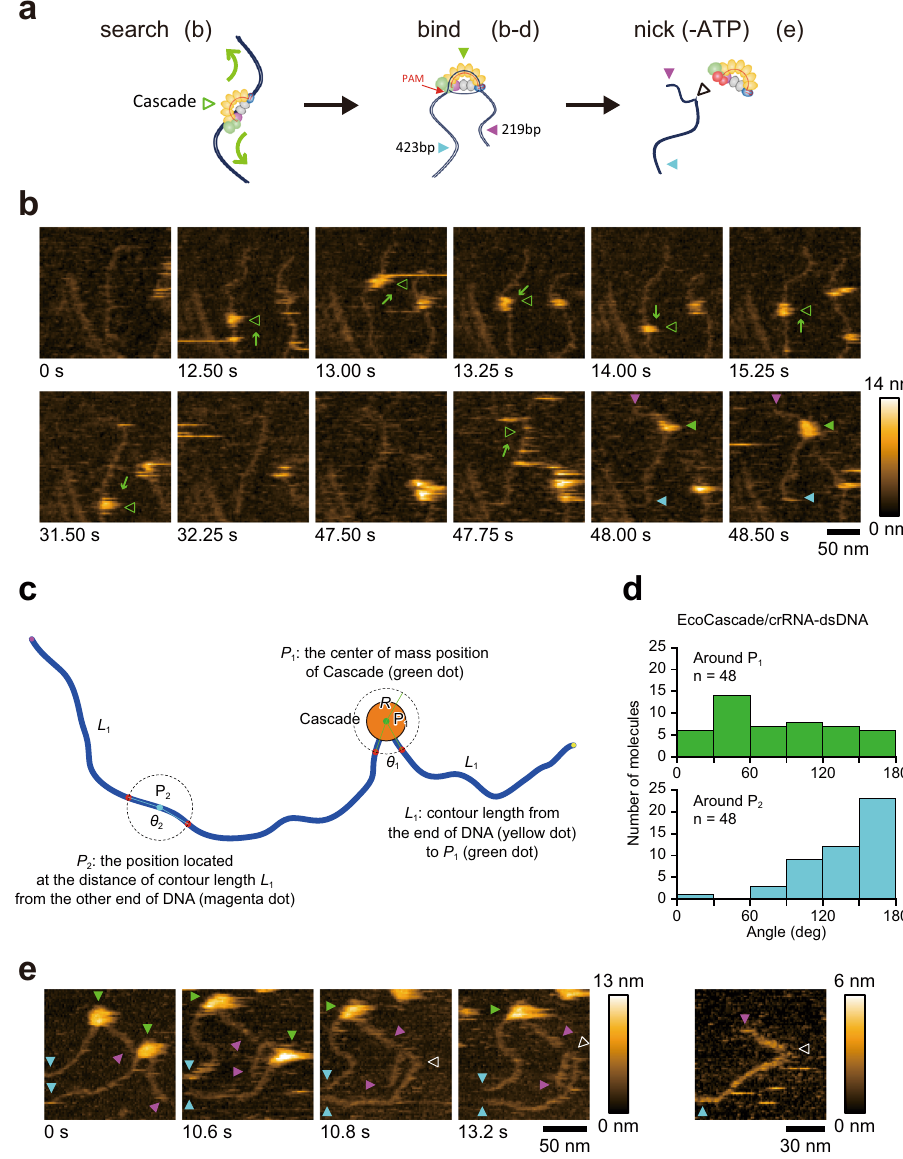
c Overview of strategies for measuring angles around Cascade. R:15nm. d HistogramsofDNAanglesaroundP 1 (top)andaroundP 2 (bottom)inEcoCascade- dsDNA. e Injection of EcoCas3 protein after immobilizing EcoCascade RNPs with the target DNA in ATP-free ( − ) reaction buffer to produce EcoCas3-mediated nicking (white triangle) at the target site (video 3). Scan area: 150 × 150 nm 2 (left 4 images)and 100× 100nm 2 (the most right image) with 80 × 80pixels;frame time: 0.2s (line rate: 400Hz). The experiment of b , e was repeated twice independently with similar